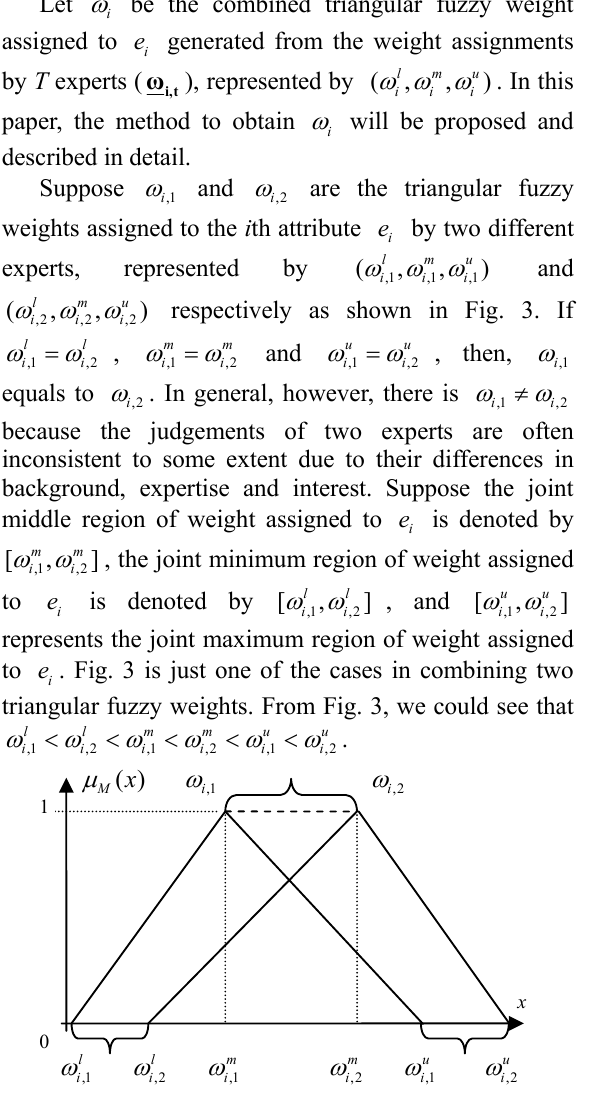
Fig. 3. Combining triangular fuzzy weights of the i th attribute derived from two experts